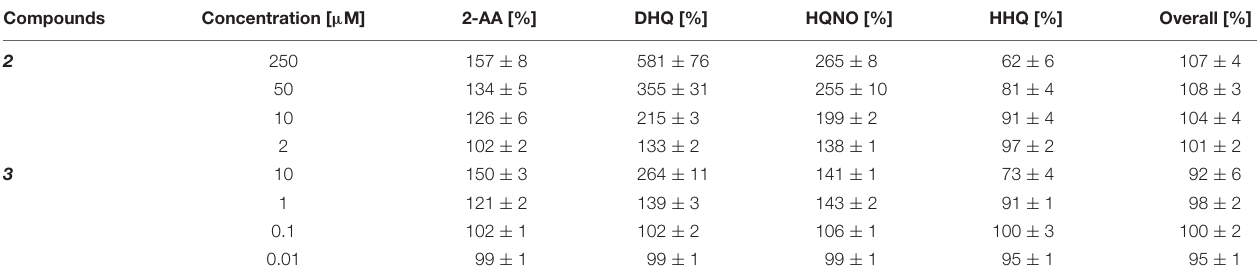
TABLE 4 | Production of pqs signal molecules in PA14 pqsH mutant after the treatment with PqsBC inhibitors. Compounds Concentration [ µ M] 2-AA [%] DHQ [%] HQNO [%]